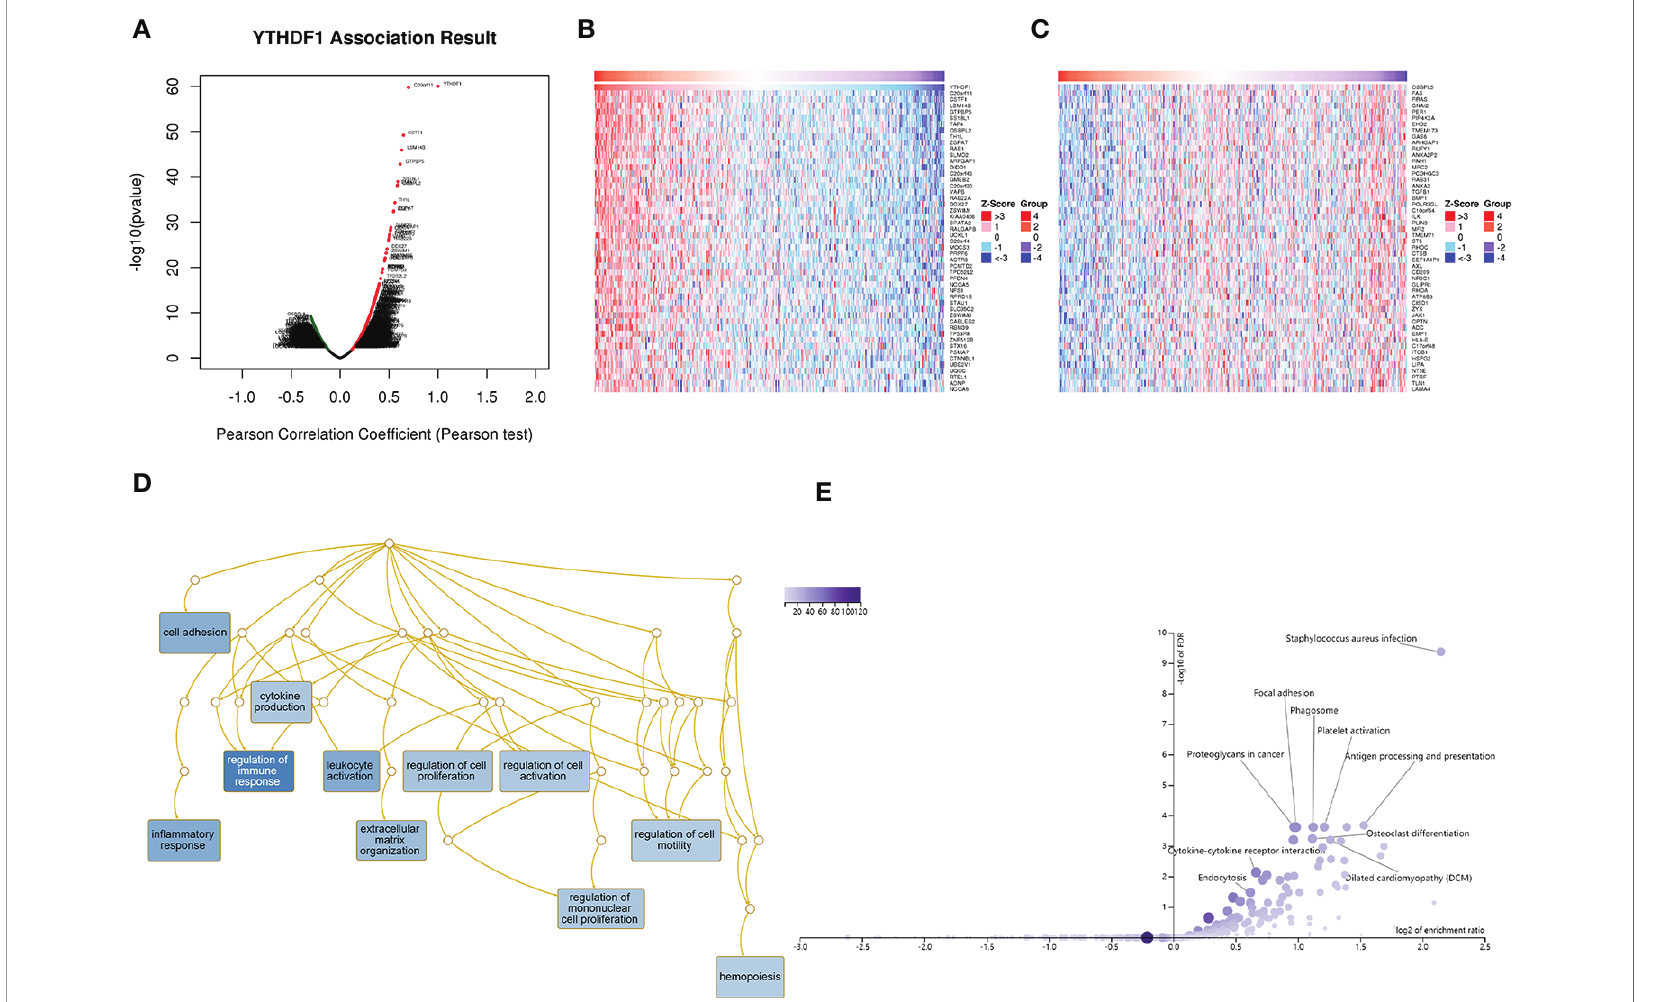
FIGURE 9 | YTHDF1 coexpression genes in BLCA analyzed by the LinkedOmics database. (A) Highly correlated genes of YTHDF1 tested by Pearson test in BLCA cohort. (B, C) Top 50 positive coexpression genes (B) and negative coexpression genes (C) of YTHDF1 in heat map in BLCA; (D) Directed acyclic graph of YTHDF1 GO analysis (biological process) in BLCA cohort. (E) Volcano plot of YTHDF1 KEGG pathways in BLCA